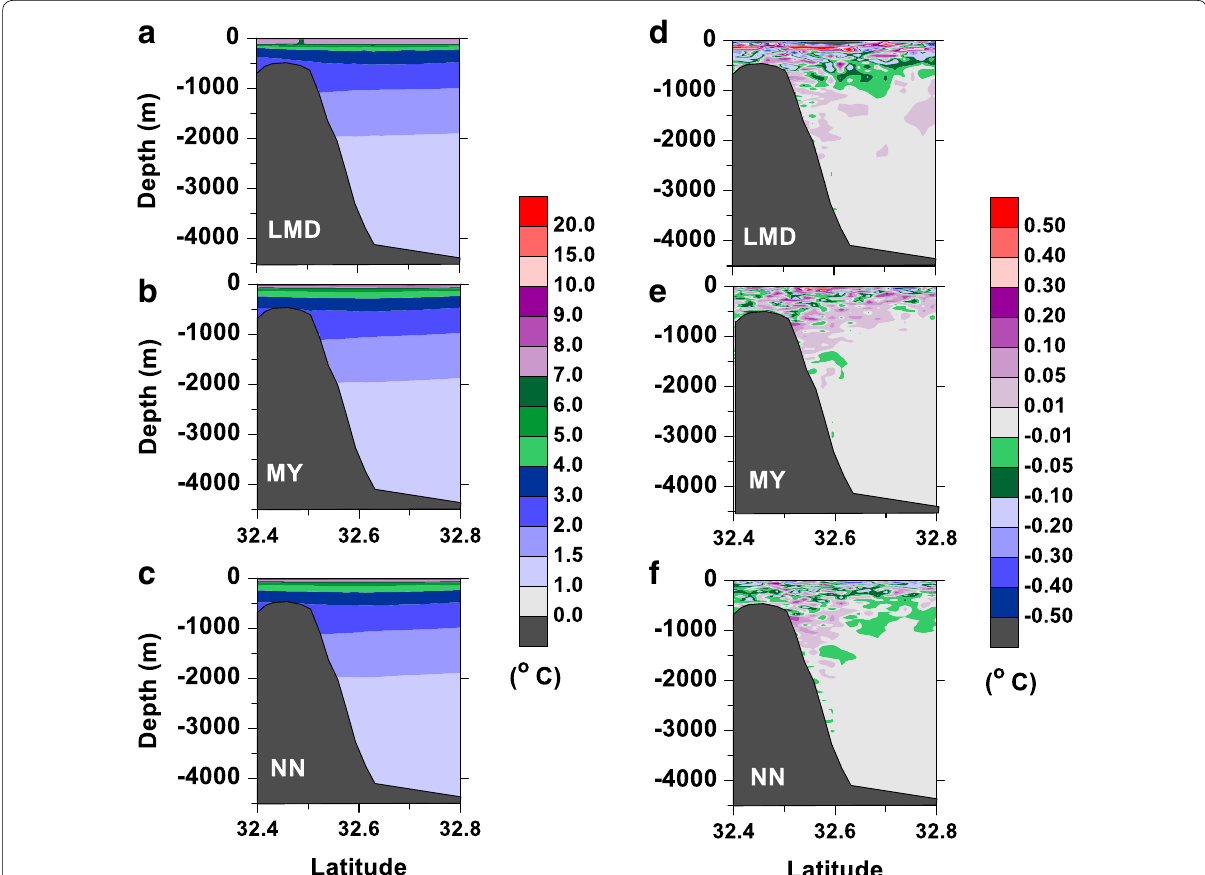
Fig. 10 The a – c potential temperatures average over the last 5 days and the d – f difference between those averaged values and the initial values after removing the values associated with advection using the a , d LMD, b , e MY, and c , f NN vertical mixing